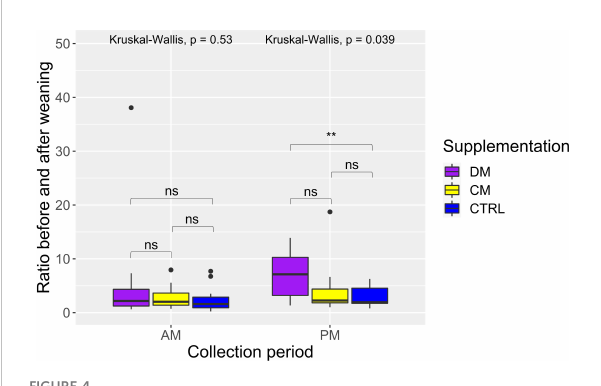
FIGURE 4 Distribution and comparison results of the salivary cortisol ratio calculated before and after weaning considering the period of collection (AM: morning and PM: afternoon) and supplementation treatment of piglets. Supplementation: DM (asinine milk); CM (skimmed cow milk); CTRL (Control without supplementation). Statistical description: ns (not signi fi cant, p > 0.05); ** (signi fi cant, p < 0.01).